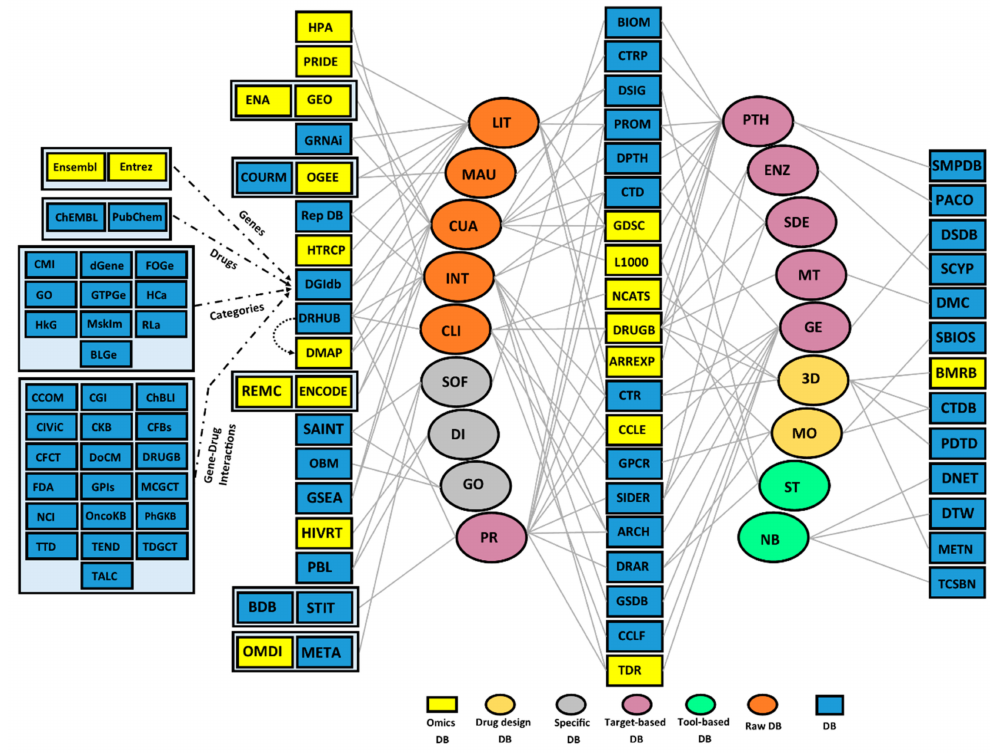
Figure 2. Key databases as primary resources for drug repositioning. Databases (DBs) can be divided into five classes, including Drug Design DB, Specific DB, Target-based DB, Tool-based DB, and Raw DB. The content of each DB is shown with an edge to the subcategories. Refer to Table S1 for a full description. DBs with omics and high-throughput datasets are colored in